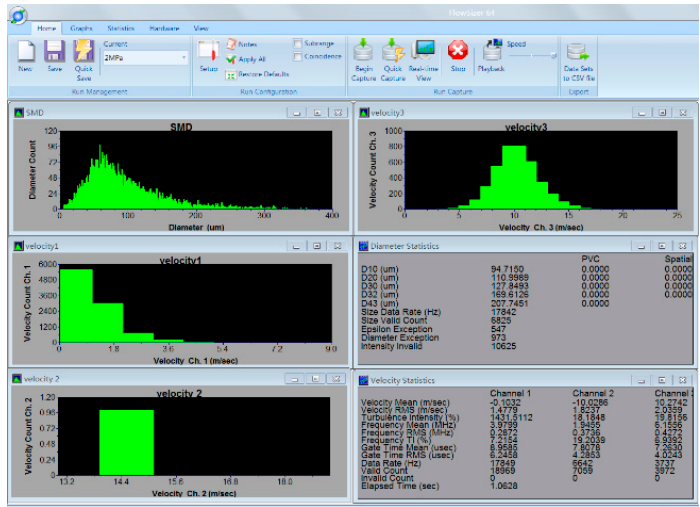
Figure 4. Flowsizer software display interface.